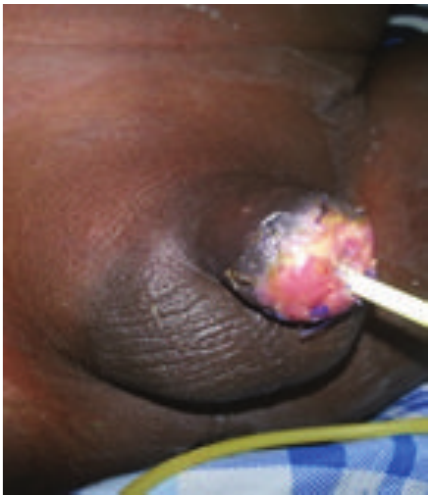
Figure 6: Glans at two weeks following surgery.